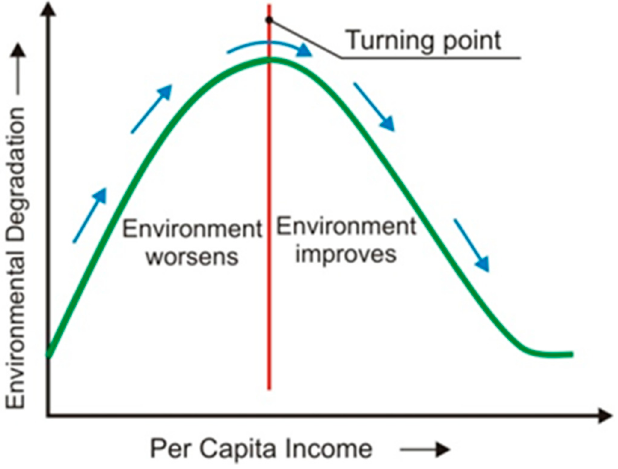
Figure 1. Environmental Kuznets curve (Authors’ creation).